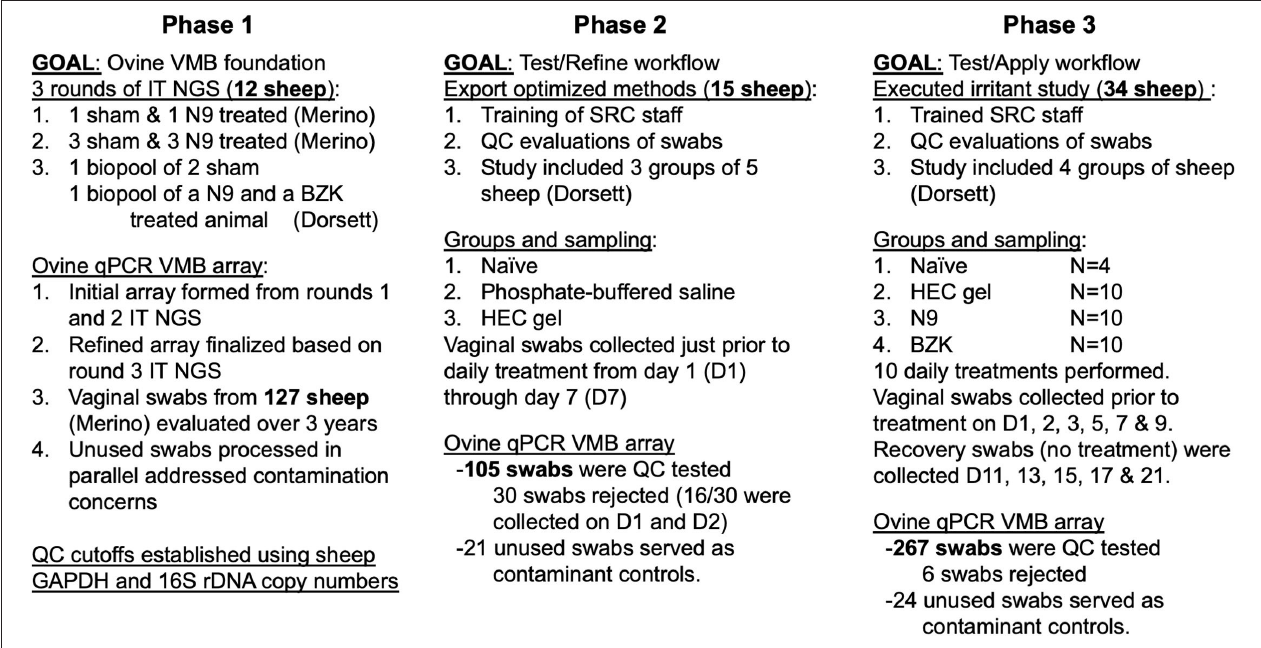
FIGURE 1 | Overall study design for the three phases of the study. The iterative approach, completed over 8 years, first established collection and analysis methods (phase 1) in two breeds of sheep housed under different conditions. The optimal methods were then exported to a second research team at a second site (phase 2), allowing for refinement of techniques and confirmation of sample shipment methods before completing an expanded evaluation (phase 3) of irritants selected to impact the ovine vaginal environment with the expectation of shifted vaginal microbiome (VMB) and inflammation development to identify the most common microbiota changes and their association with inflammatory